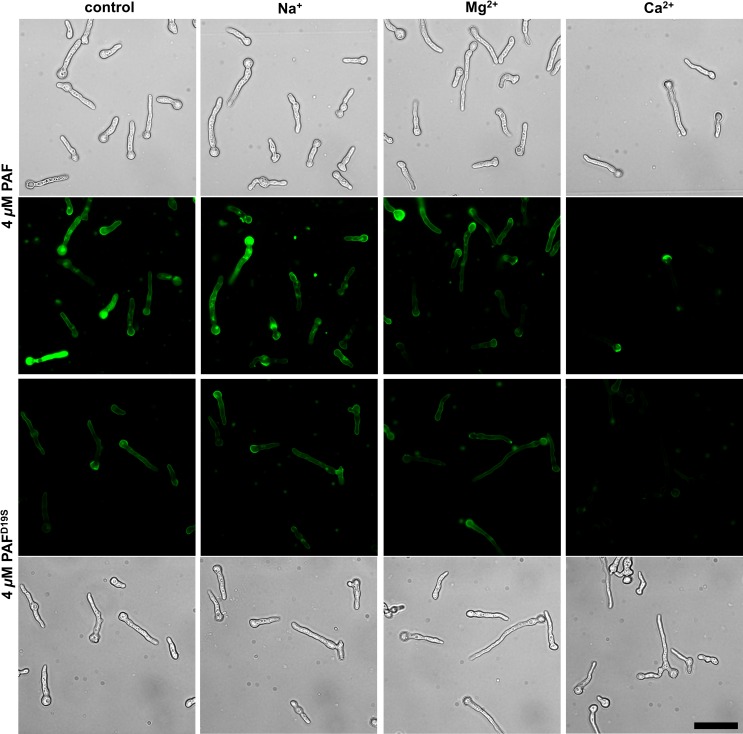
The effect of the addition of ions to the growth medium on binding and uptake of BODIPY-labelled PAF and PAFD19S.Conidia of N. crassa were germinated in the presence of 4 μM BODIPY-PAF or BODIPY-PAFD19S for 6 h in liquid medium supplemented with 1 mM NaCl, MgCl2 and CaCl2, respectively. In the control the 0.2 x Vogel’s growth medium was without ion supplementation. Scale bar = 30 μm.